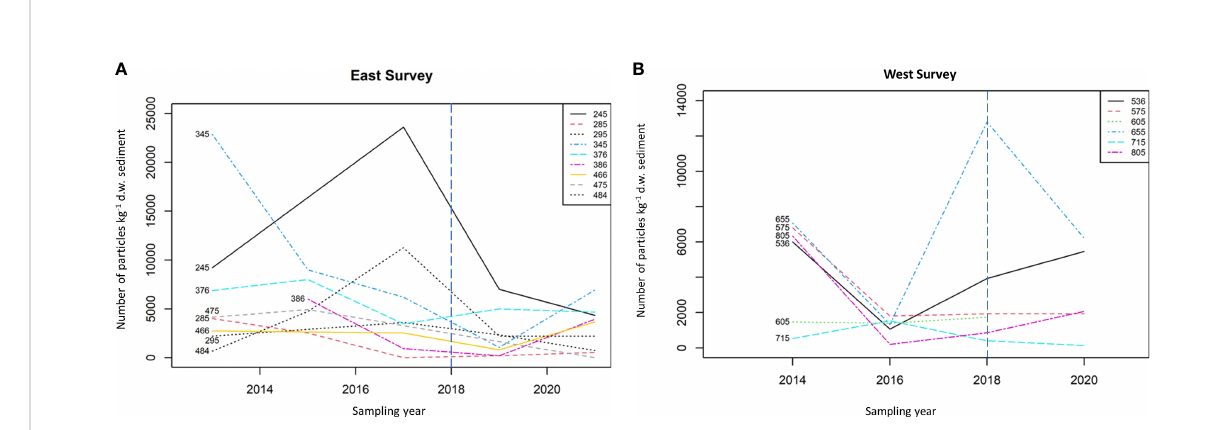
FIGURE 2 Mean number of particles kg -1 d.w. sediment per station for (A) the East and (B) the West surveys. The vertical blue line at 2018 indicates the change in sampling method from the use of archive samples to dedicated microplastic